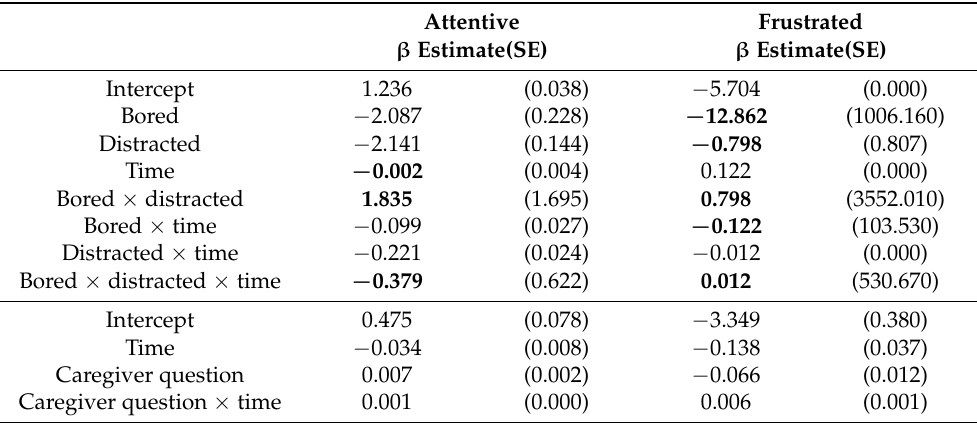
Table 5. Logistic regression analysis of predictors of attentive and frustration